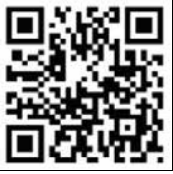
407)Figure 1: First-generation QR Code (Demir et al. , 2015: